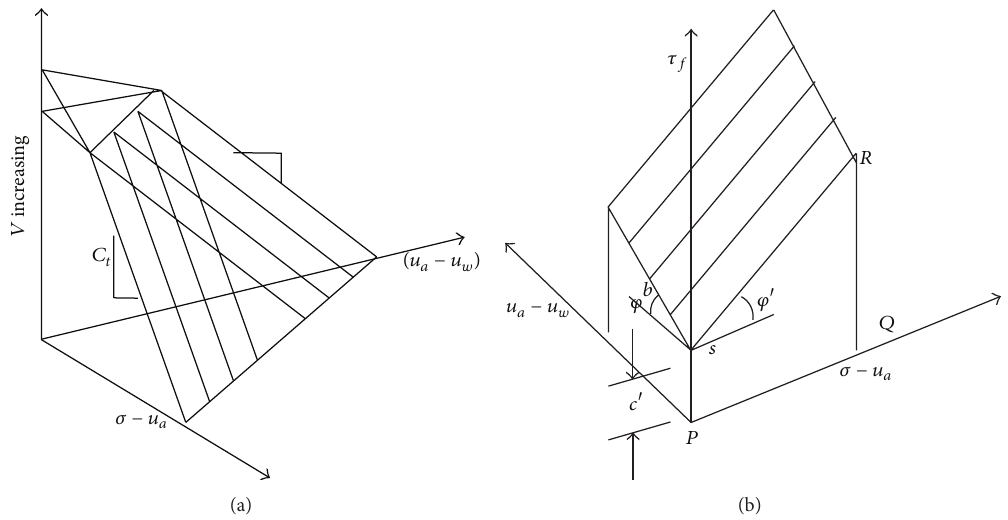
Figure 4: The compression state model of unsaturated soil (a) and its shear strength (b) [10].